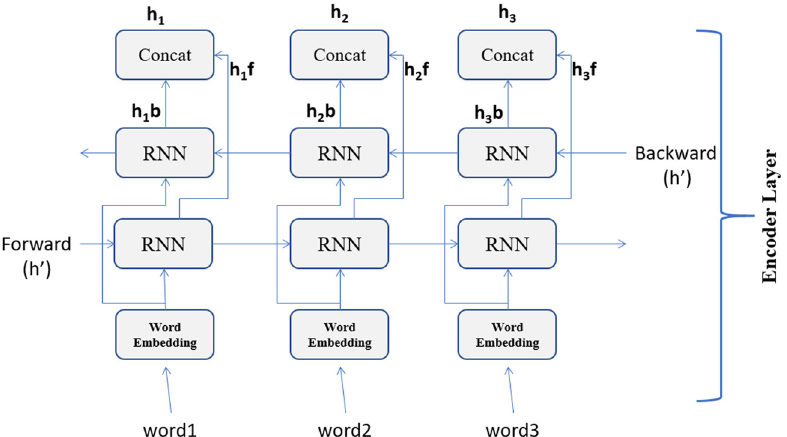
Figure 9: Encoder